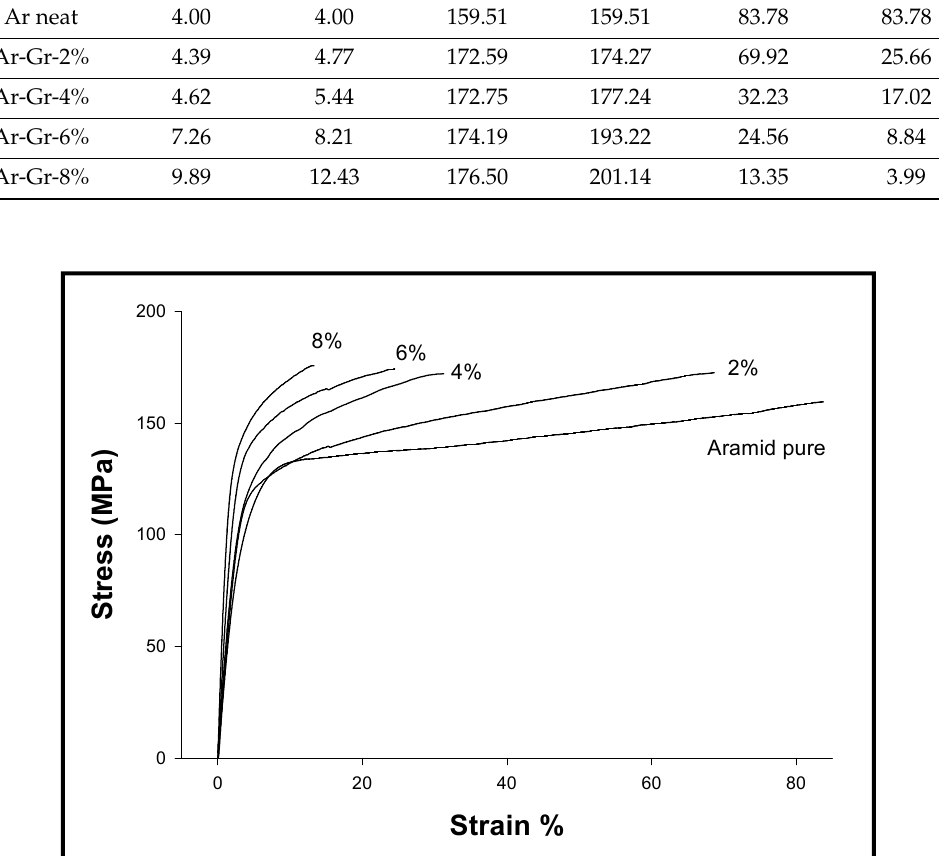
Figure 9. Stress-strain curves for ArGr composites with different Wt.% of Gr.